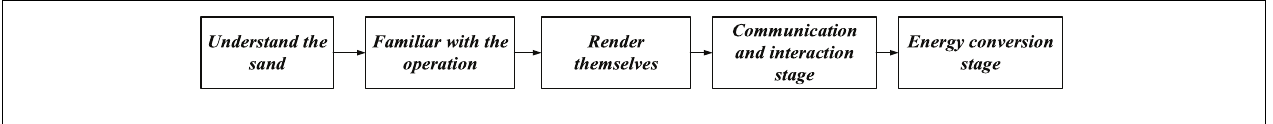
FIGURE 3 | Psychological Sand Play Therapy (SPT) process.